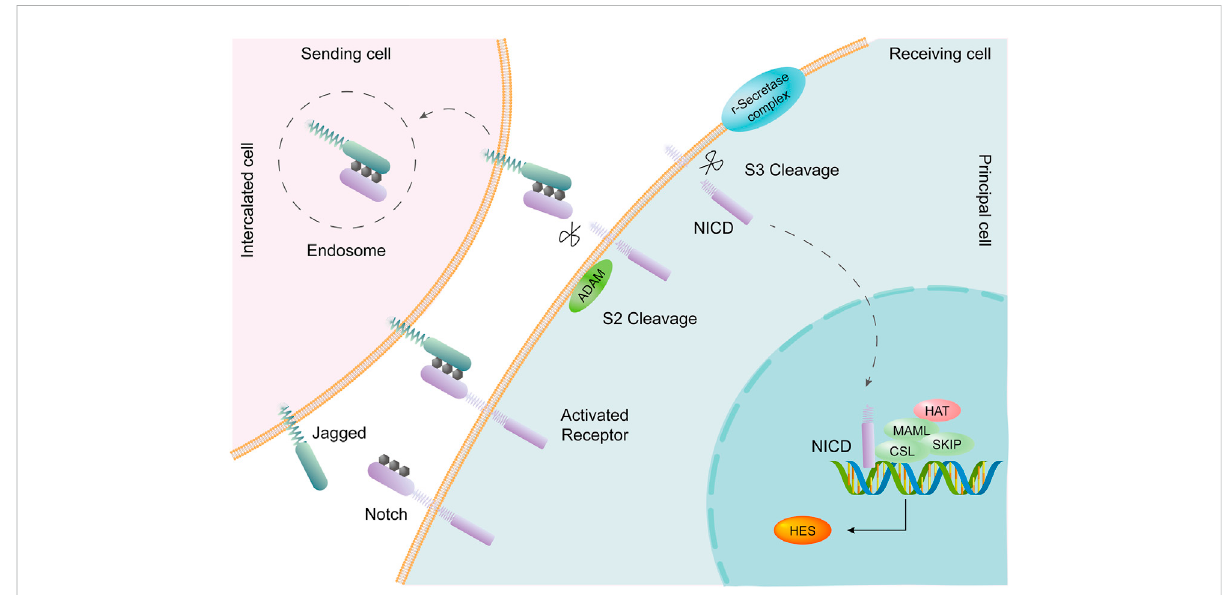
FIGURE 5 The Notch signaling pathway is involved in transformation between PCs and ICs. Intercalated cells (ICs) express the Notch ligand Jagged. Principalcells(PCs)expresstheNotchreceptor.ActivationoftheNotchsignalingpathwaypromotesthetransitionofICstoPCsinthecollectingduct of the adult